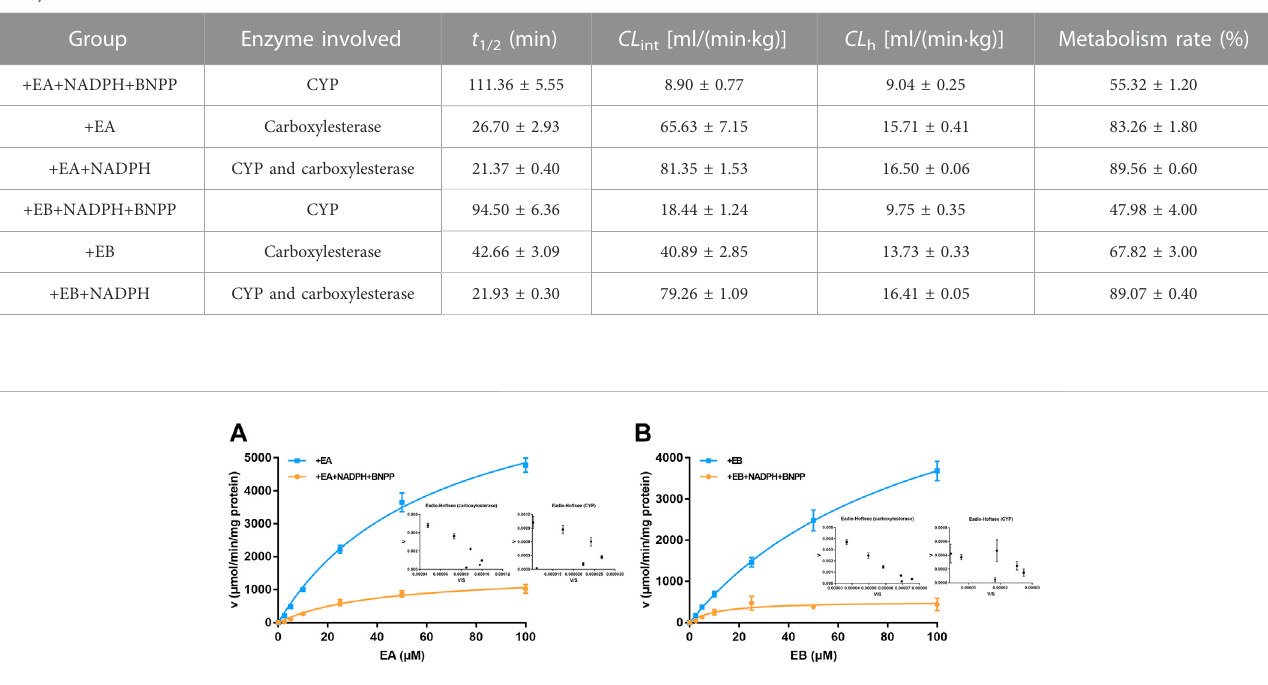
TABLE 2 Oxidative and hydrolysis kinetic parameters of EA and EB in HLMs (mean ± SD; n =